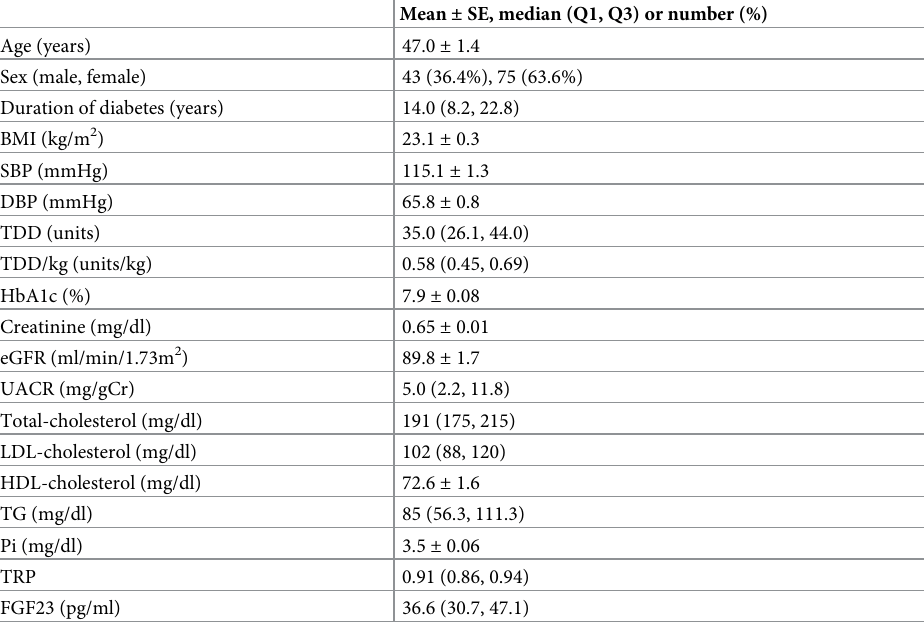
Table 1. Clinical characteristics of the